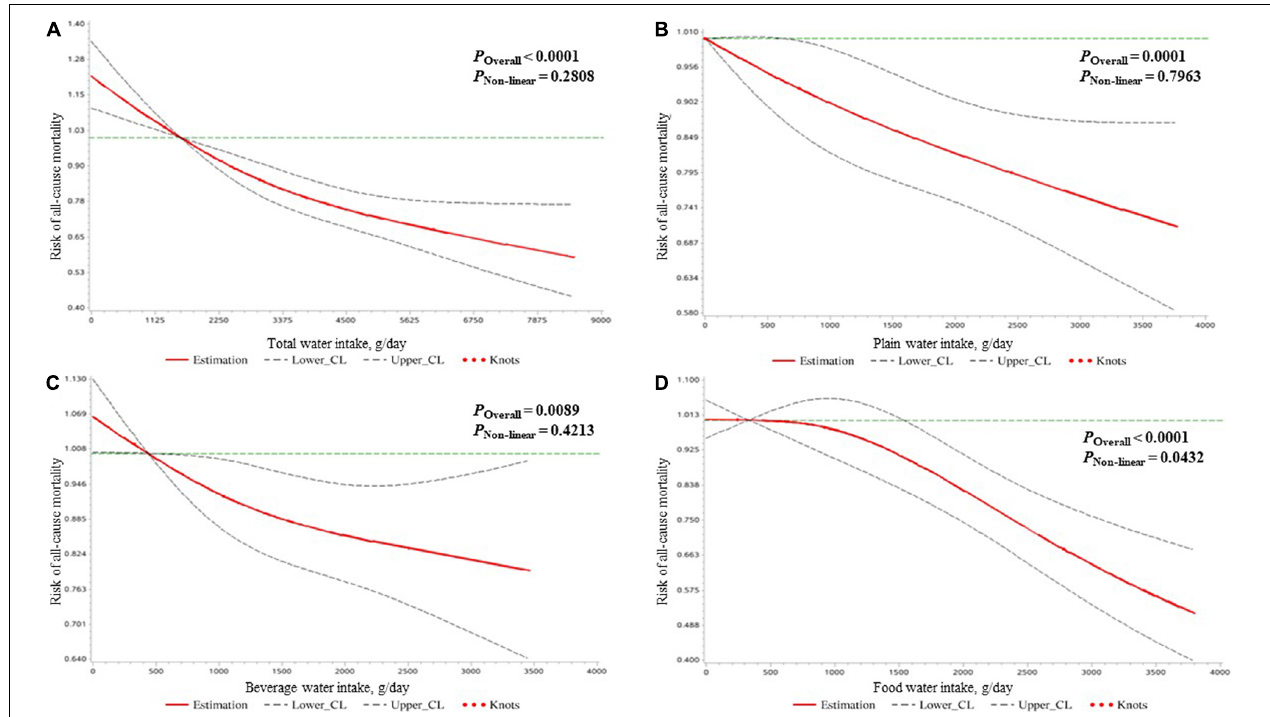
FIGURE 1 | The dose–response relationships of the amount of water intake [expressed by total water (A) , plain water (B) , beverage water (C) , and food water (D) ] with the mortality risk due to all causes in all participants clarified by restricted cubic spline